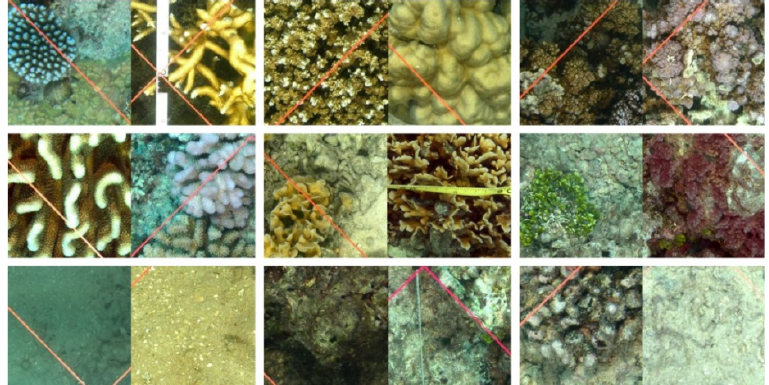
Figure A2. A subset of the MLC dataset showing two examples for each class. First row: Acropora , Porites , Montipora . Second row: Pocillopora , Pavona , Macroalgae. Third row: Sand, Turf algae,